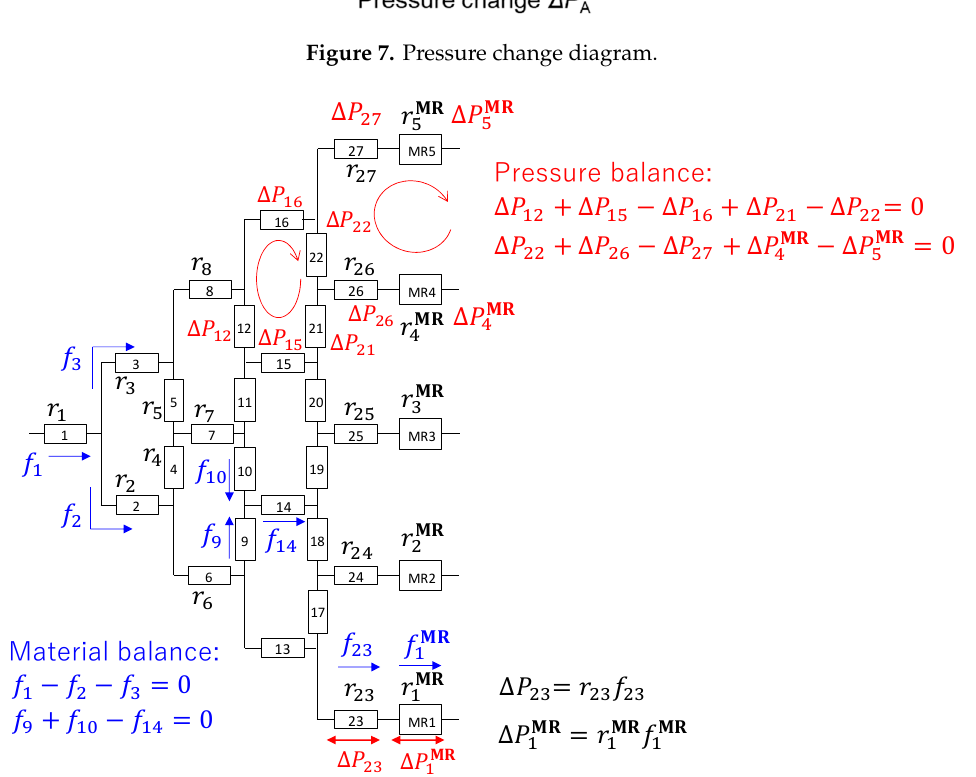
Catalysts 2019 , 9 , x FOR PEER REVIEW